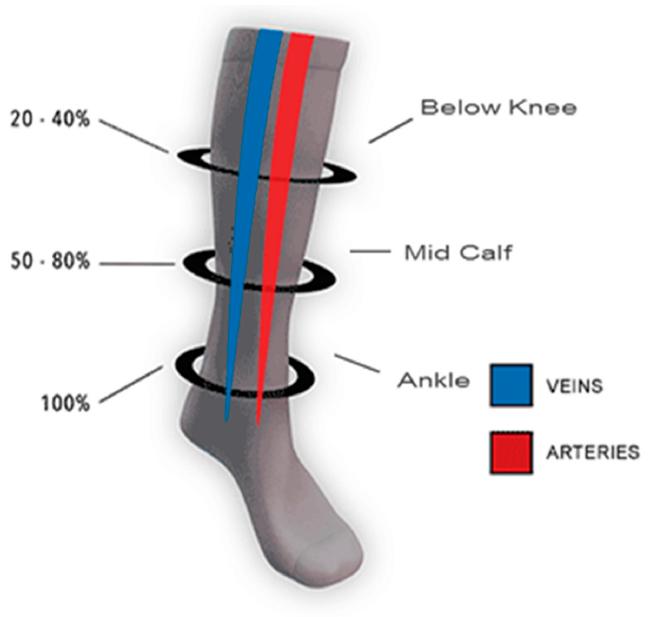
Figure 3. Pressure levels in the compression